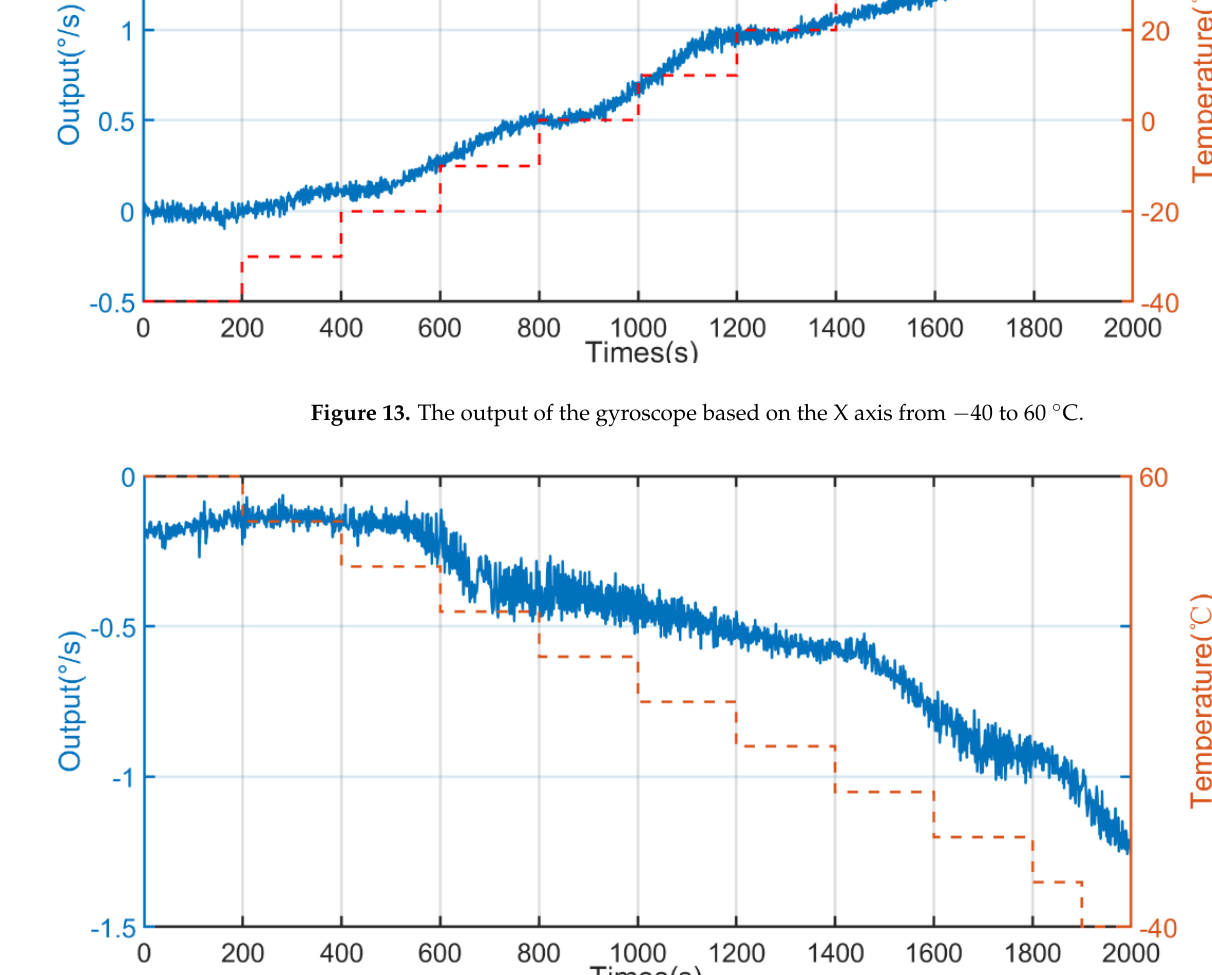
Figure 14. The output of the gyroscope based on the X axis from 60 to −40 °C .